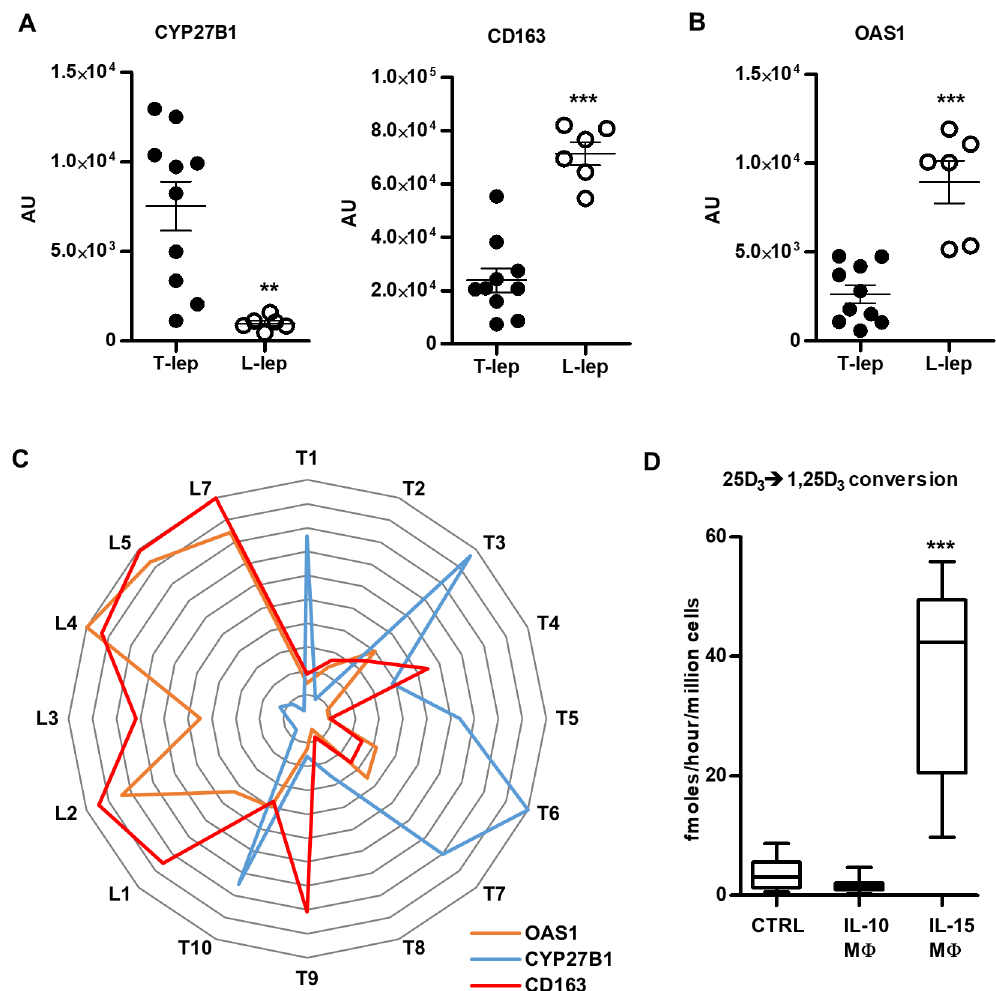
Fig 3. CYP27B1 gene expression is negatively correlated with OAS1 gene expression in in vitro studies and in leprosy lesions. (A) Correlation of CYP27B1 and CD163 as well as (B) OAS1 gene expression from microarray analysis of T-lep (n = 6) and L-lep (n = 5) human skin lesions. (C) Radar plot of CYP27B1, CD163 and OAS1 expression in T-lep and L-lep lesions normalized to the highest value in the experiment. (D) Primary human monocytes were treated with 10 μ g/mL IL-10 or 200ng/mL IL-15 for 48 hours. Control (Ctrl) M F were derived by treating monocytes with 10 3 U/mL IL-4 for 48 hours. IL-10 M F and IL-15 M F were incubated with radiolabeled 25D 3 for 5 hours and conversion of 25D 3 to 1,25D 3 was measured by HPLC. Data are shown as mean ± SEM, n = 3. Statistical significance was determined using one-way ANOVA. ( (cid:3)(cid:3) p (cid:20) 0.01, (cid:3)(cid:3)(cid:3) p (cid:20)